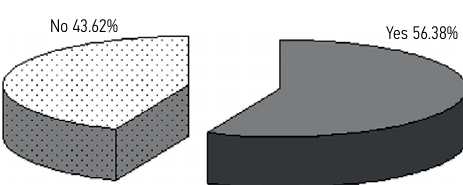
Fig. 1. Traffic accidents involvement